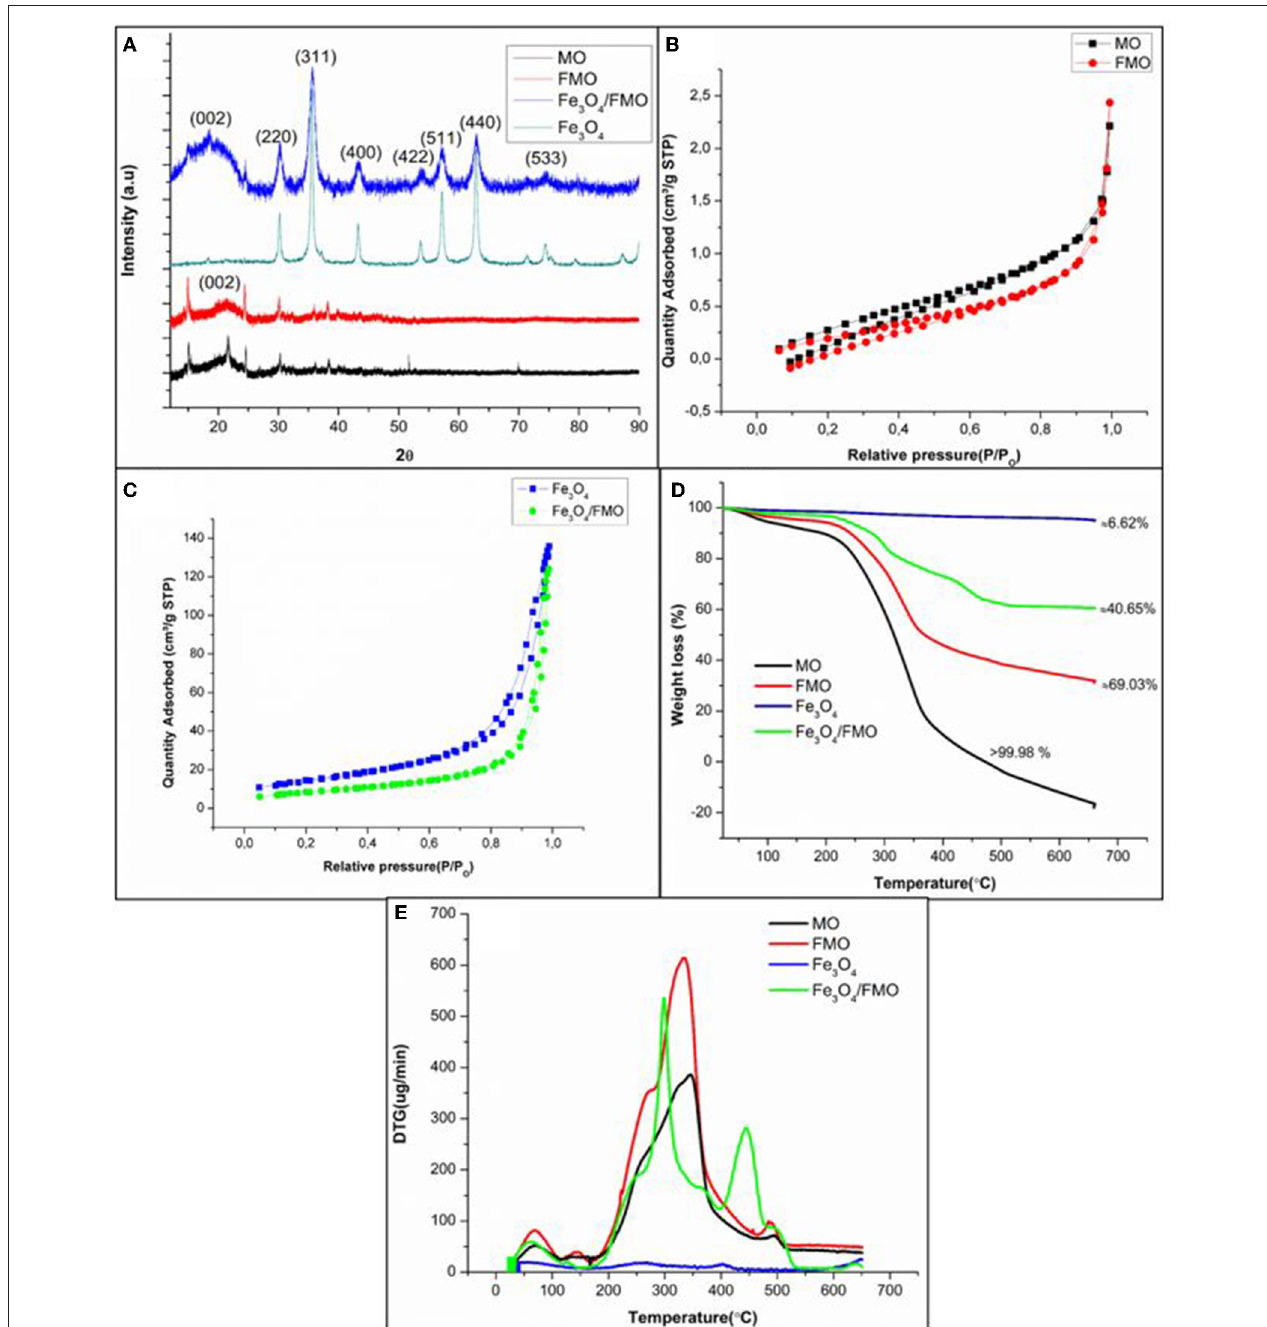
FIGURE 4 | Characterization of MO, FMO, Fe 3 O 4 , and Fe 3 O 4 /FMO using (A) XRD (B,C) Nitrogen adsorption/desorption isotherms (D) TGA curves and (E) DTG